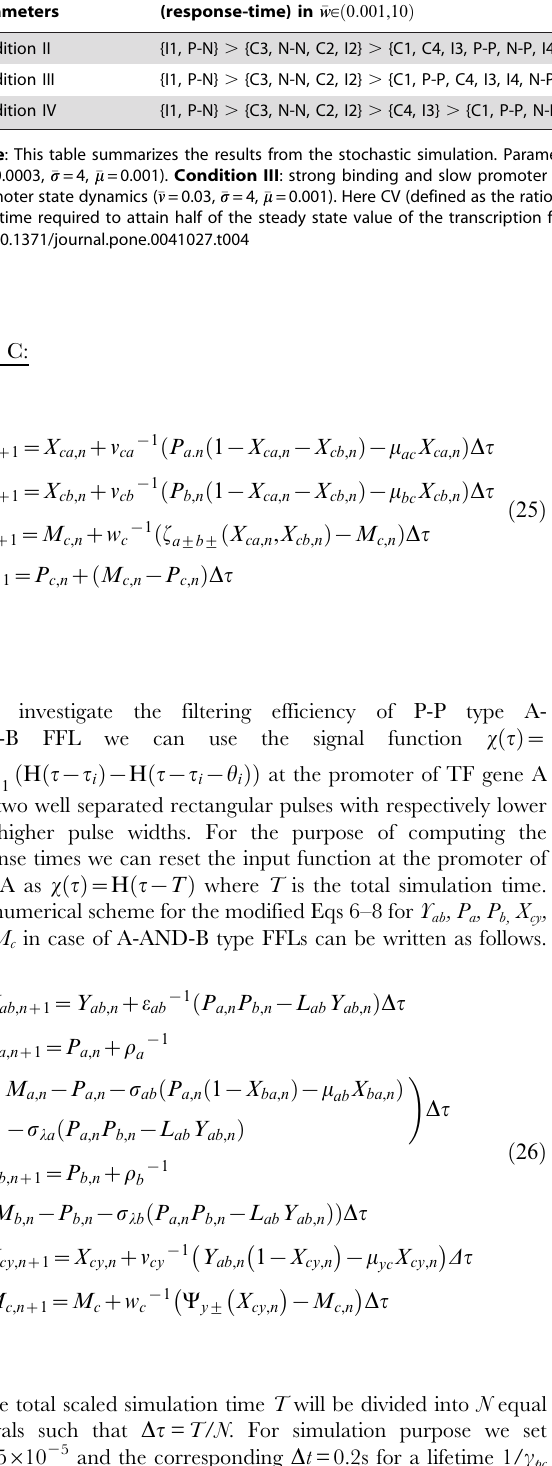
Table 4. Segregation patterns of CV (response time) at weak and strong binding conditions.